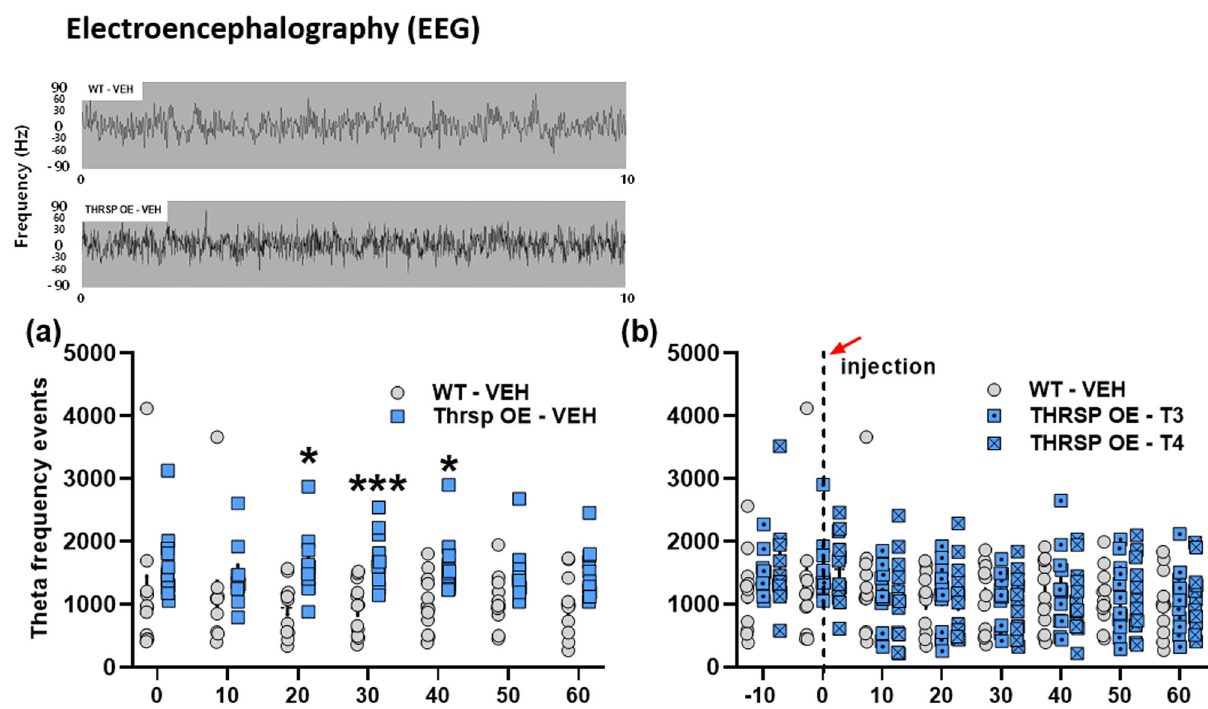
Fig. 8 Effects of TH replacement on the excess theta waves in THRSP OE mice. Separate cohorts of mice were treated with LT3 and LT4 (10 mg kg − 1 ) for seven days, and the a theta waves frequency events and b total theta frequencies were recorded and analyzed ( n = 12 mice/group; a repeated measures two-way ANOVA, F (1,22) = 11.3, P = 0.003; b repeated measures two-way ANOVA, F (2,33) = 0.105, P = 0.901). Values are presented as the mean ± S.E.M. * P < 0.05 and *** P < 0.01 (relative to WT), by repeated measures two-way ANOVA with Bonferroni ’ s multiple comparison tests. LT3 and LT4 normalized the theta waves in THRSP OE mice similar to WT-VEH.